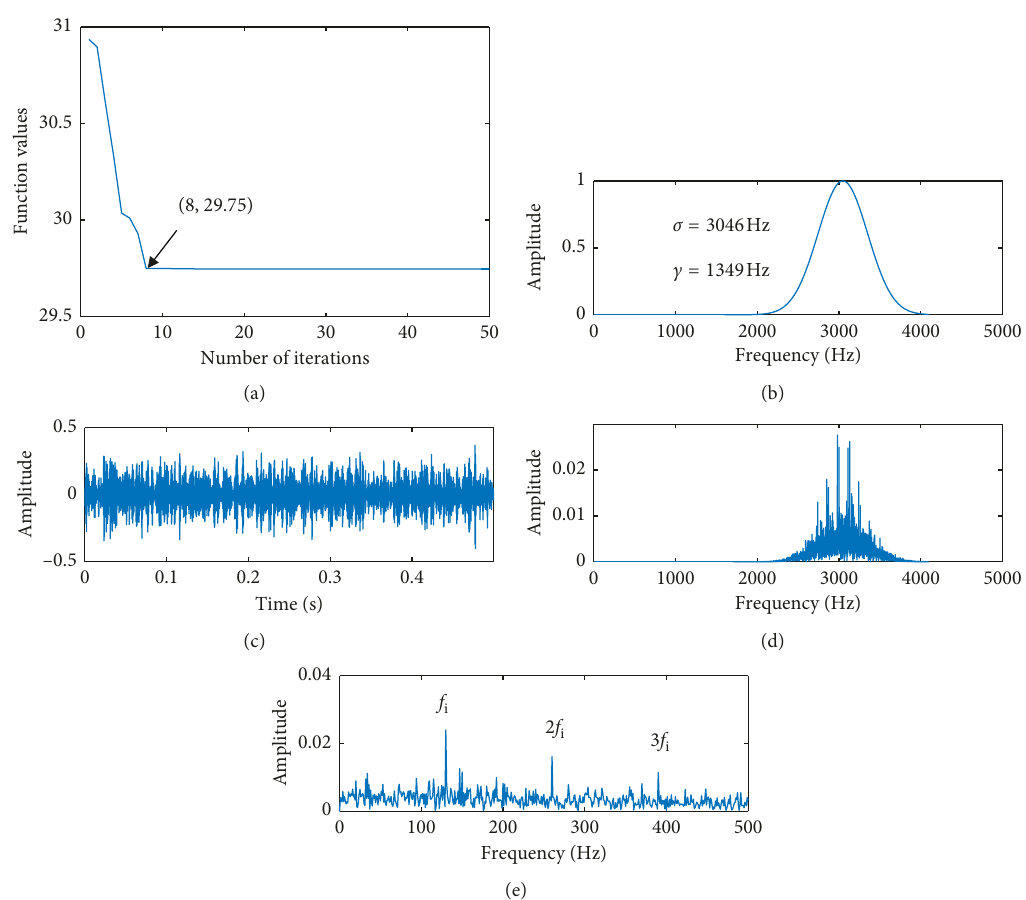
Figure 6: Diagnosis results of the simulation signal by the proposed approach: (a) iteration curves for determining the optimal ARLW parameters; (b) FS of the optimal ARLW for detecting the inner ring defect information; (c) TW of the filtered signal obtained by (b); (d) FS of (c); (e) ES of (d).